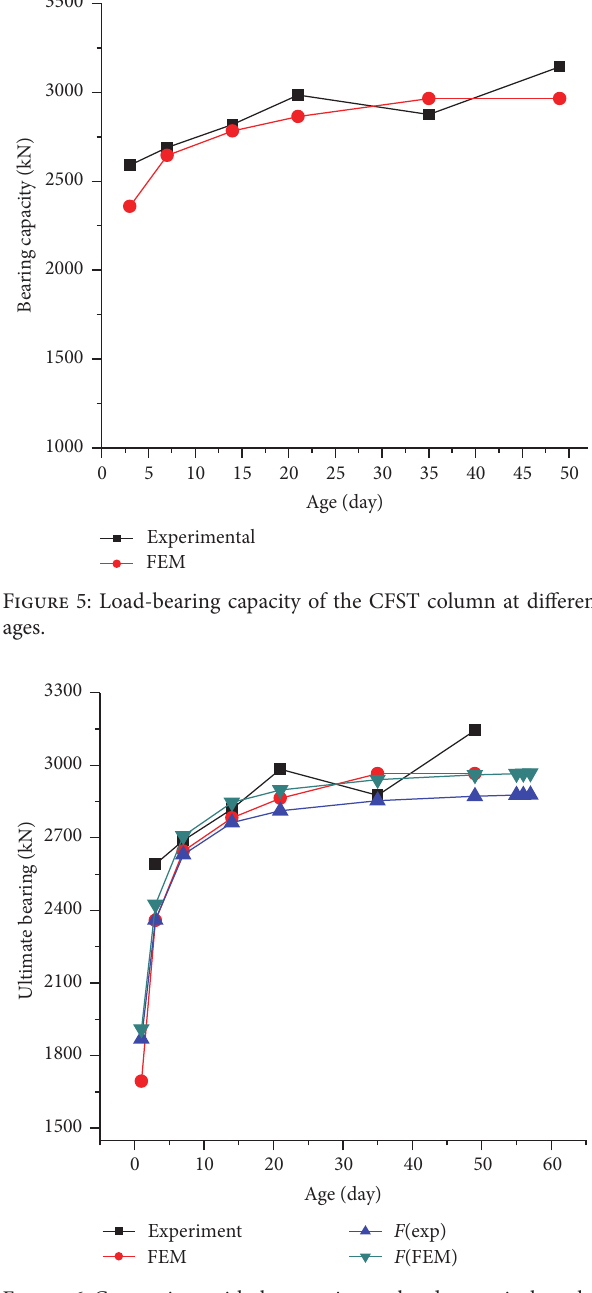
Figure 6: Comparison with the experimental and numerical